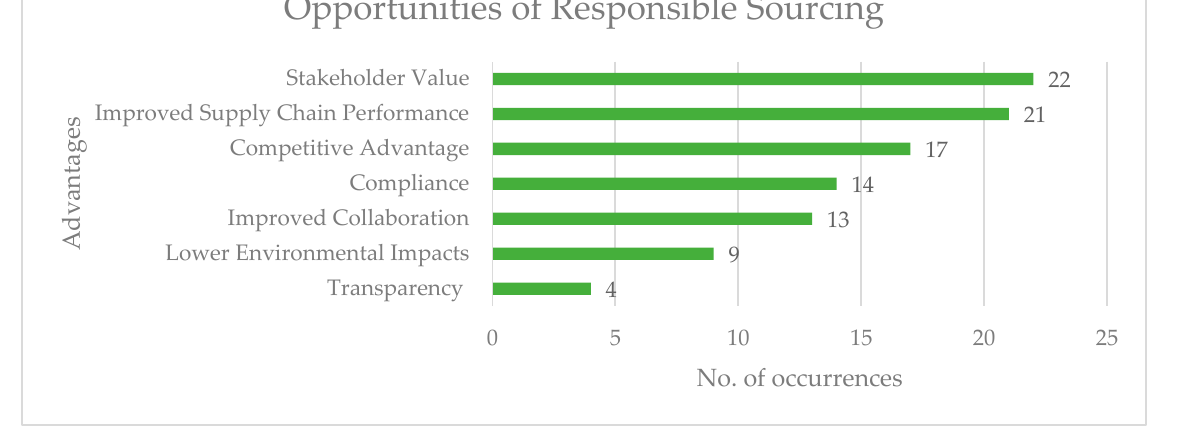
Figure 5. This shows the opportunities (n = 7) provided by responsible sourcing and the frequency of their reporting in the AEC publications (n = 80) used in the literature review.